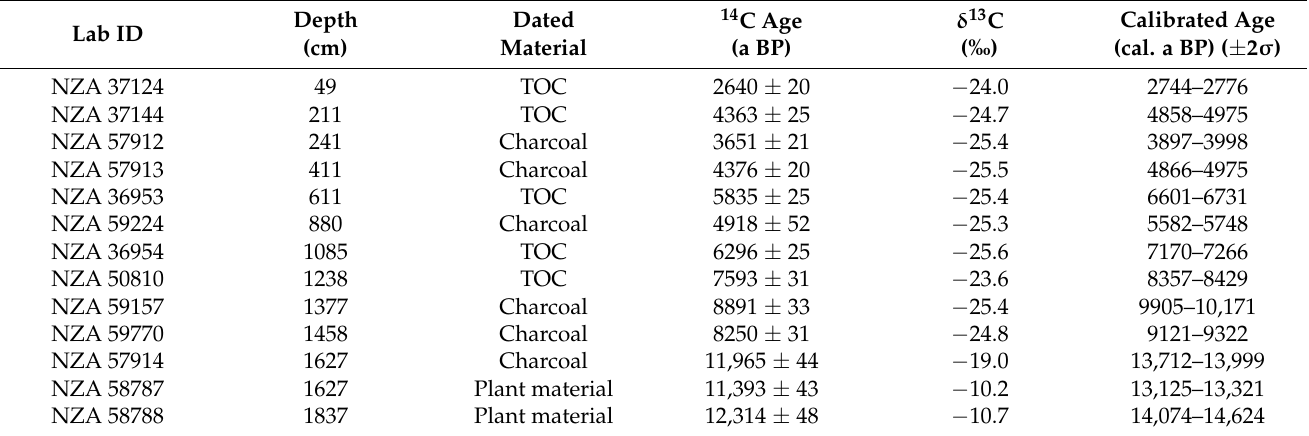
Table 1. AMS 14 C ages and calendar ages obtained for core